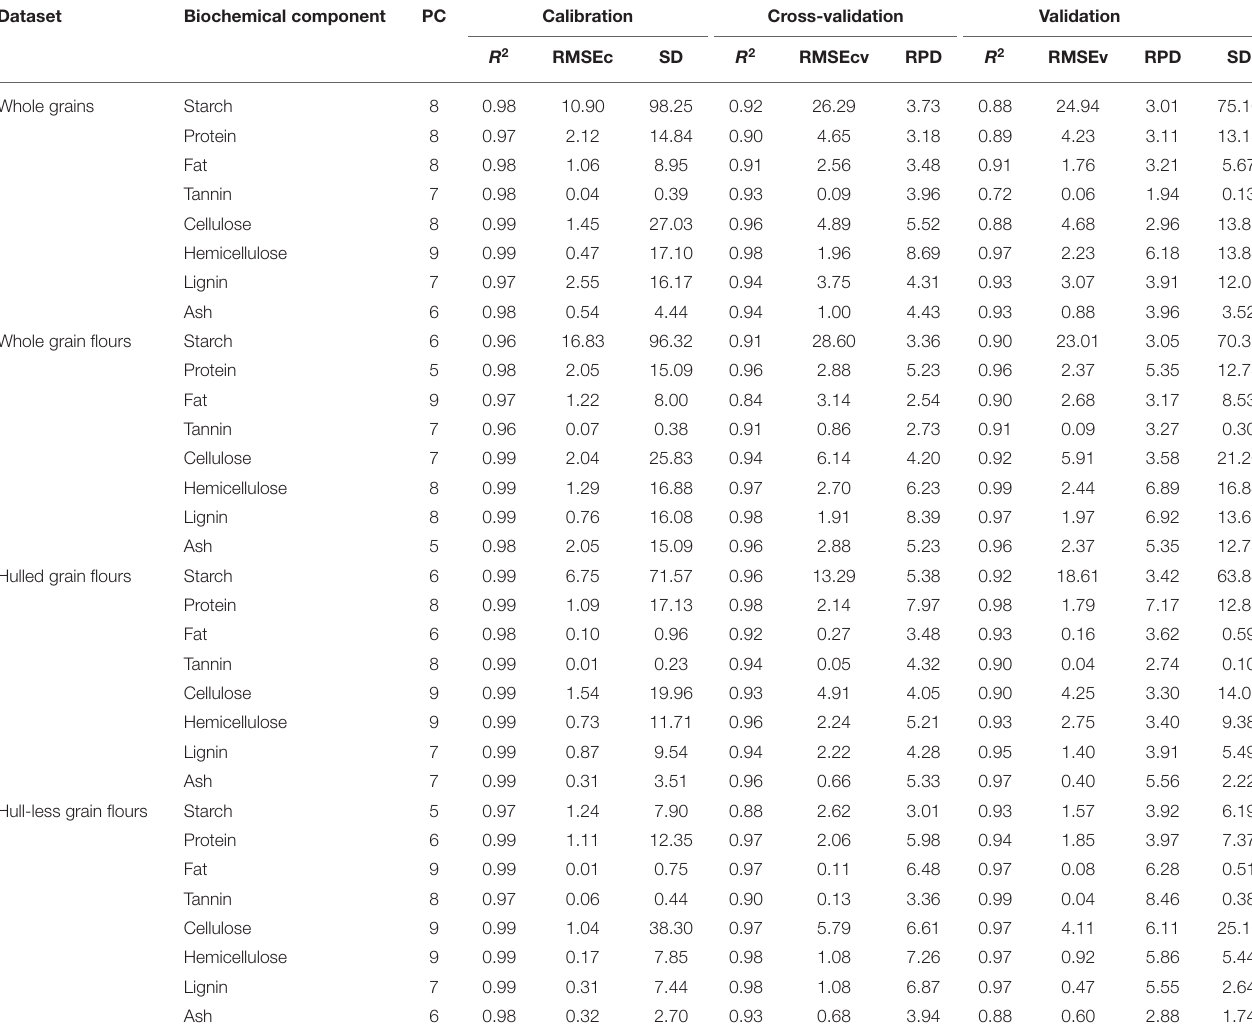
TABLE 3 | Statistics of PLSR models constructed using FT-NIR spectroscopy to determine starch, protein, fat, tannin, cellulose, hemicellulose, lignin, and ash in distinct types of sorghum grains (whole grains, whole grain flours, hulled, and hull-less grain flours) used for calibration, validation, and cross-validation subsets.